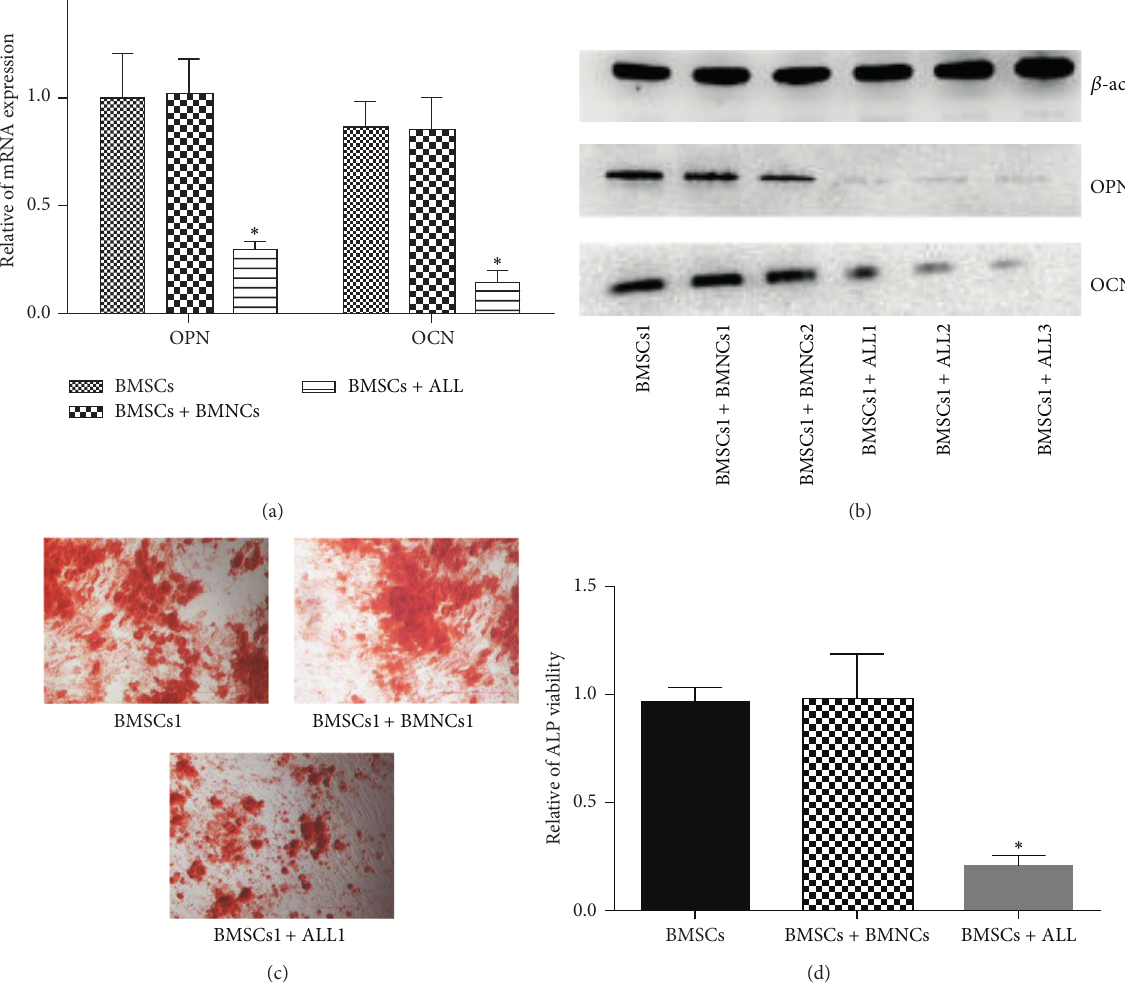
Figure 1: Effect of ALL cells on osteoblast differentiation of bone mesenchymal stem cells (BMSCs). BMSCs obtained from healthy bone marrow mononuclear cells (BMNCs) were cocultured with acute lymphoblastic leukemia (ALL) cells from six ALL patients or BMNCs from three healthy donor in osteogenesis induction medium for 3 days or 14 days. (a) The mRNA expression of Osteopontin (OPN) and Osteocalcin (OCN) were analyzed using real-time RT-PCR. (b) OPN and OCN protein were assessed by western blot analysis after 3-day coculture. (c) Calcium deposits were detected using von Kossa staining. (d) Alkaline phosphatase (ALP) levels were detected using an ALP kit ( ∗ 𝑃 < 0.05 versus BMSCs cultured alone or coculture with